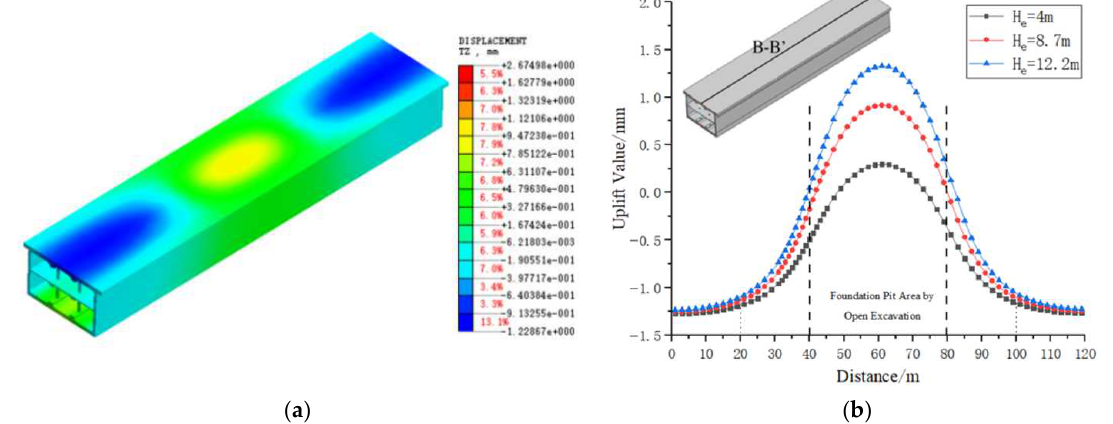
Figure 5. Schematic diagram of longitudinal uplift of station. ( a ) Comparison of uplift on top plate B-B’ line; ( b ) comparison of uplift on top plate B-B’ line. B-B’ line; ( b ) comparison of uplift on top plate B-B’